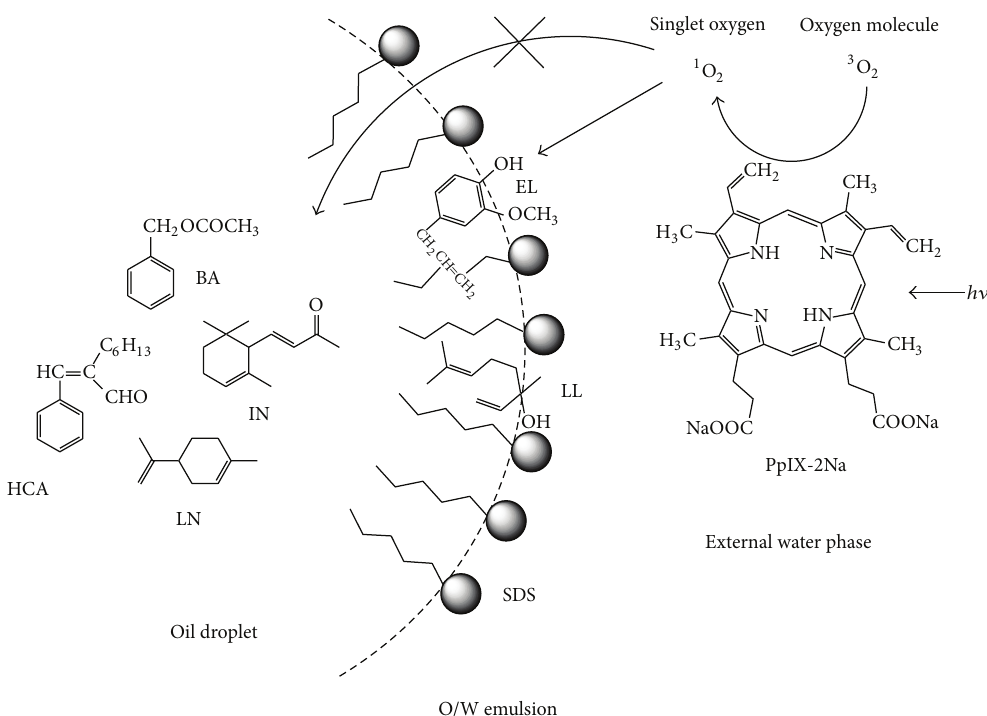
Figure 8: Scheme of oxidation decomposition mechanism of synthetic perfumes in O/W emulsion by 1 O 2 generated by PpIX-2Na.